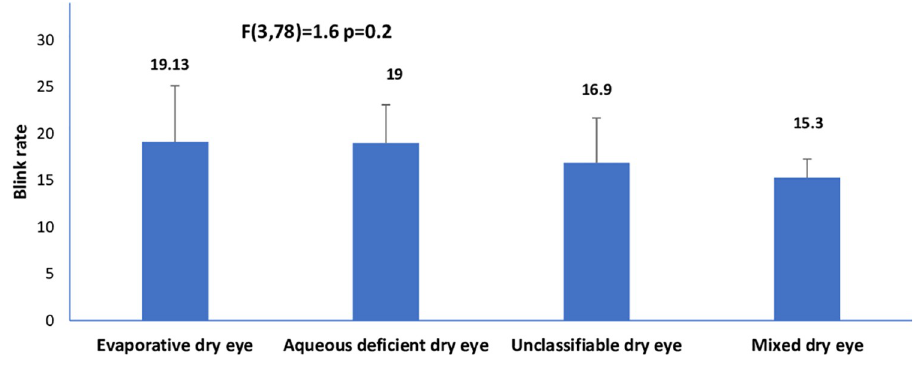
Fig 5. Means of blink rate across clinical subtypes of dry